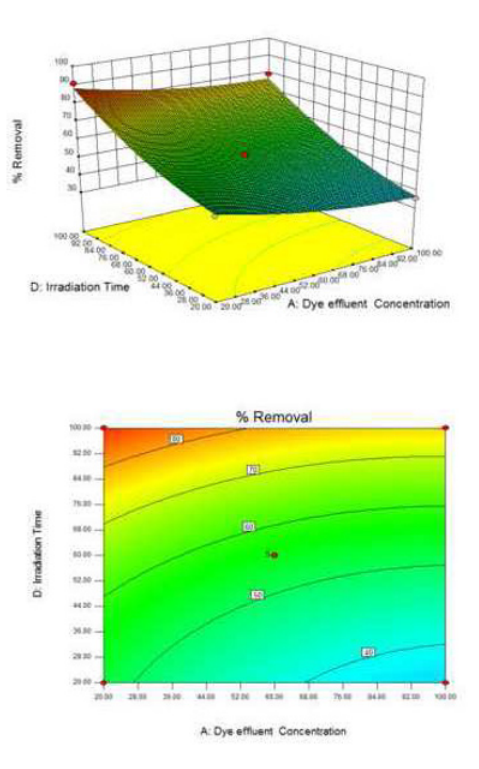
Figure 6. 3D Response surface (Top) and contour plots (Bottom) showing the interaction between catalytic dosage and pH for solar induced photocatalytic decolourization of dye ef- fluent (Dye effluent concentration 60 mg L − 1 ; Irradiation Time 60